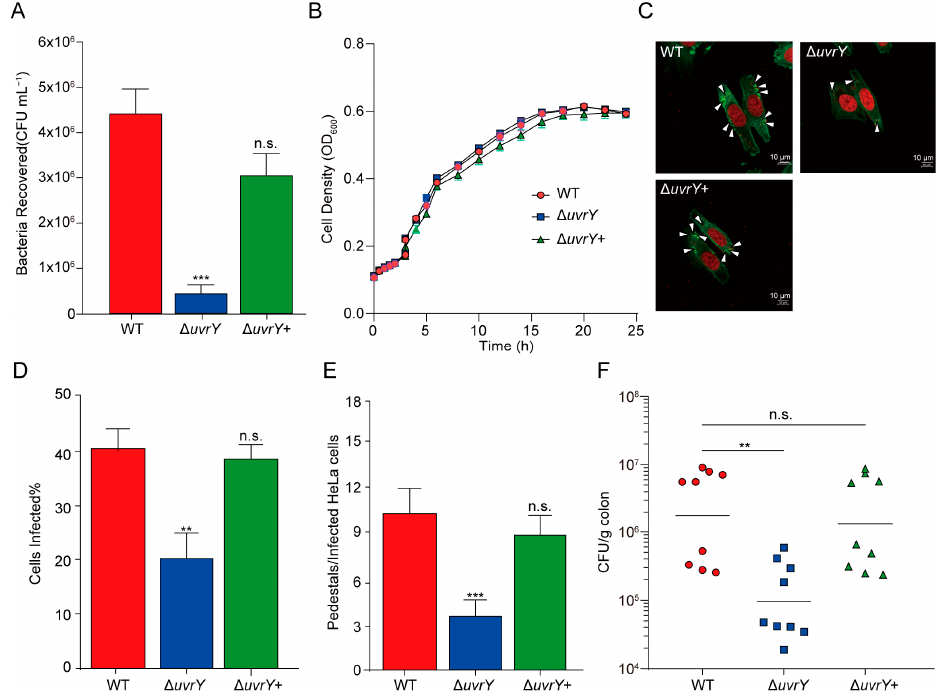
Figure 1. UvrY positively affects the adherence capability of EHEC O157:H7 to the host. ( A ) A bar plot showing the adherence ability of WT, ∆ uvrY , and ∆ uvrY + strains to HeLa cells ( n = 3). ( B ) A line plot showing the growth curves of WT, ∆ uvrY , and ∆ uvrY + strains in DMEM for 24 h ( n = 3). ( C ) Photos showing the HeLa cells infected with WT (left), ∆ uvrY (right), and ∆ uvrY + (below) strains after 3 h post-infection. Green color represents the staining with fluorescein isothiocyanate-labeled phalloidin for actin visualization; red color represents the staining with proidium iodide for nuclei visualization. A/E lesions were indicated by white arrowheads in each photo. Scale bar is 10 µ m. ( D ) A bar plot showing the quantification of infected HeLa cells percentage after co-culture with WT, ∆ uvrY , and ∆ uvrY + strains ( n = 50). ( E ) A bar plot showing the pedestals formation numbers in each infected HeLa cell by WT, ∆ uvrY , and ∆ uvrY + strains. Fifty cells were counted for each strain ( n = 50). Significance was determined using two-tailed unpaired Student’s t -test ( A , D , E ). ( F ) A scatter plot showing the mice colonization bacteria CFU numbers after inoculation with WT, ∆ uvrY , and ∆ uvrY + strains at 6 h post-infection ( n = 9). Horizontal bars represent the median. Significance was determined by Mann–Whitney rank-sum test. ** represents p ≤ 0.01; *** represents p ≤ 0.001; n.s. represents no significant difference.